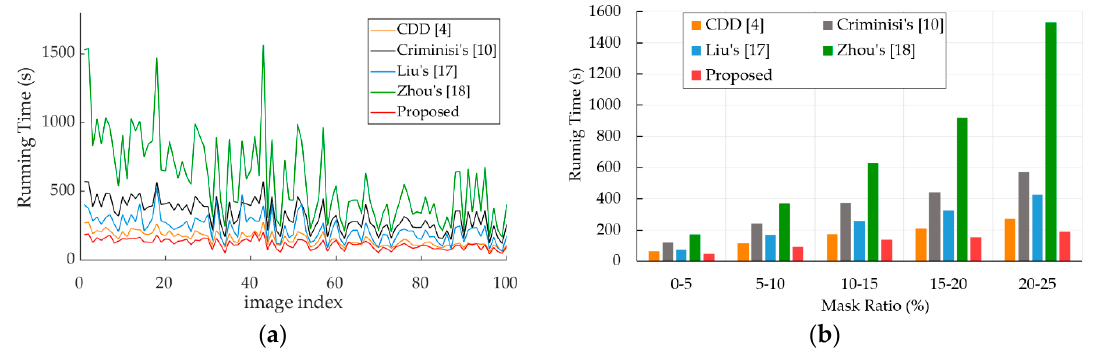
Figure 14. Comparison of running time for different methods. ( a ) Running time of 100 inpainted results; ( b ) Effect of mask ratios on the mean running time.